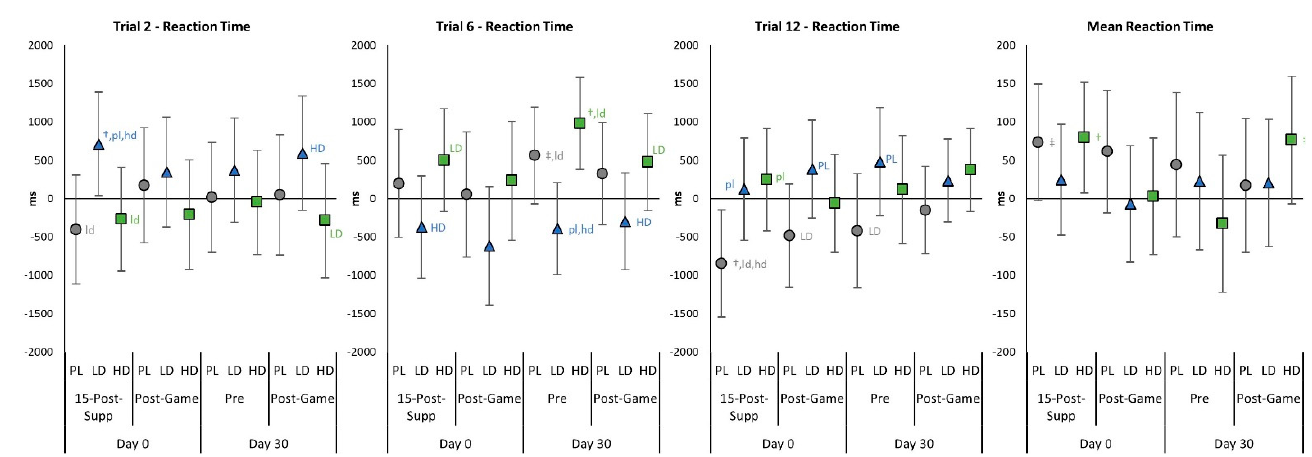
Figure 7. Psychomotor Vigilance Task Test changes with 95% confidence intervals from Day 0, pre- game (Pre) values for the placebo (PL), low-dose (LD), and high-dose (HD) groups. † represents p < 0.05 from Pre values while ‡ represents p > 0.05 to p < 0.10 effect. 15-min-Post-Supp represents data obtained 15 min after supplementation, and Post-Game represents data obtained after competitively playing video games for 60 min. Group di ff erences ( p < 0.05) are shown as di ff erences from placebo (pl), low-dose (ld), and high-dose (hd) groups, while statistical tendencies ( p > 0.05 to p < 0.10) are shown in large cases (PL, LD, HD).